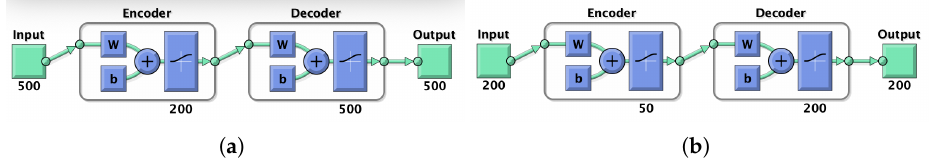
Figure 6. The structure of SAE: ( a ) the structure of the first SAE (the encoder output is the input of second SAE in ( b )); ( b ) the structure of the second